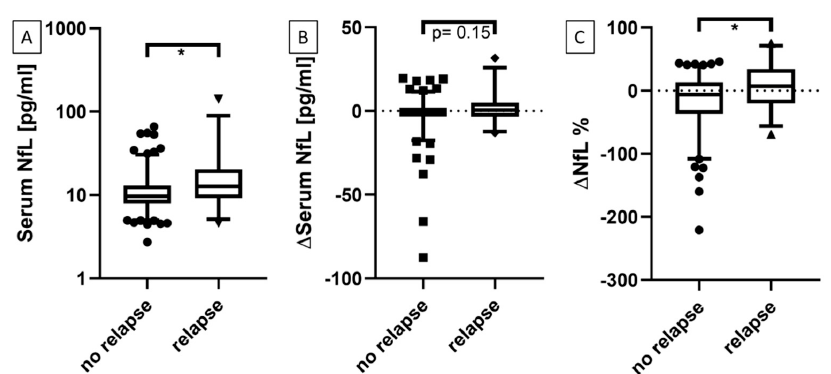
Figure 1. Serum NfL and time points with or without an active relapse. ( A ) Comparison of serum NfL levels during time points with and without an active relapse. ( B ) Comparison of the change of serum NfL between a time point with an active relapse and the previous time point. ( C ) Comparison of the percentage change of serum NfL between a time point with an active relapse and the previous time point. * p < 0.05.